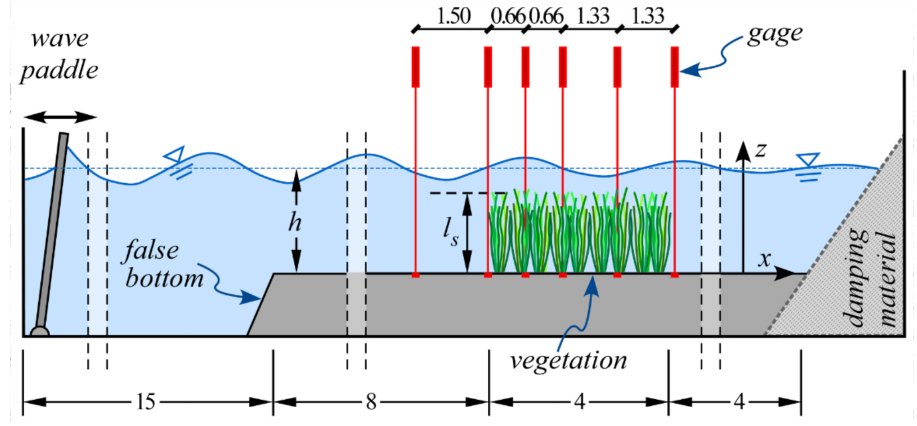
Figure 1. Scheme of the wave apparatus setup. Distances are in